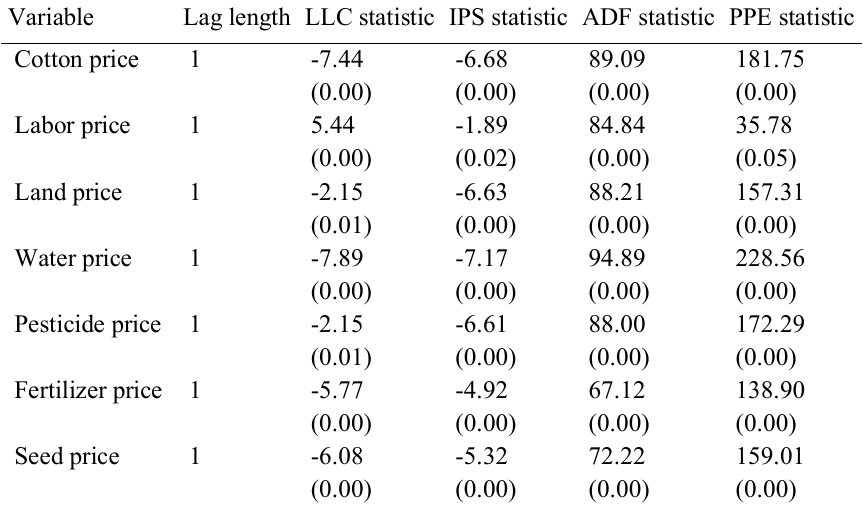
Table 1. Results of panel unit root tests for cotton crop